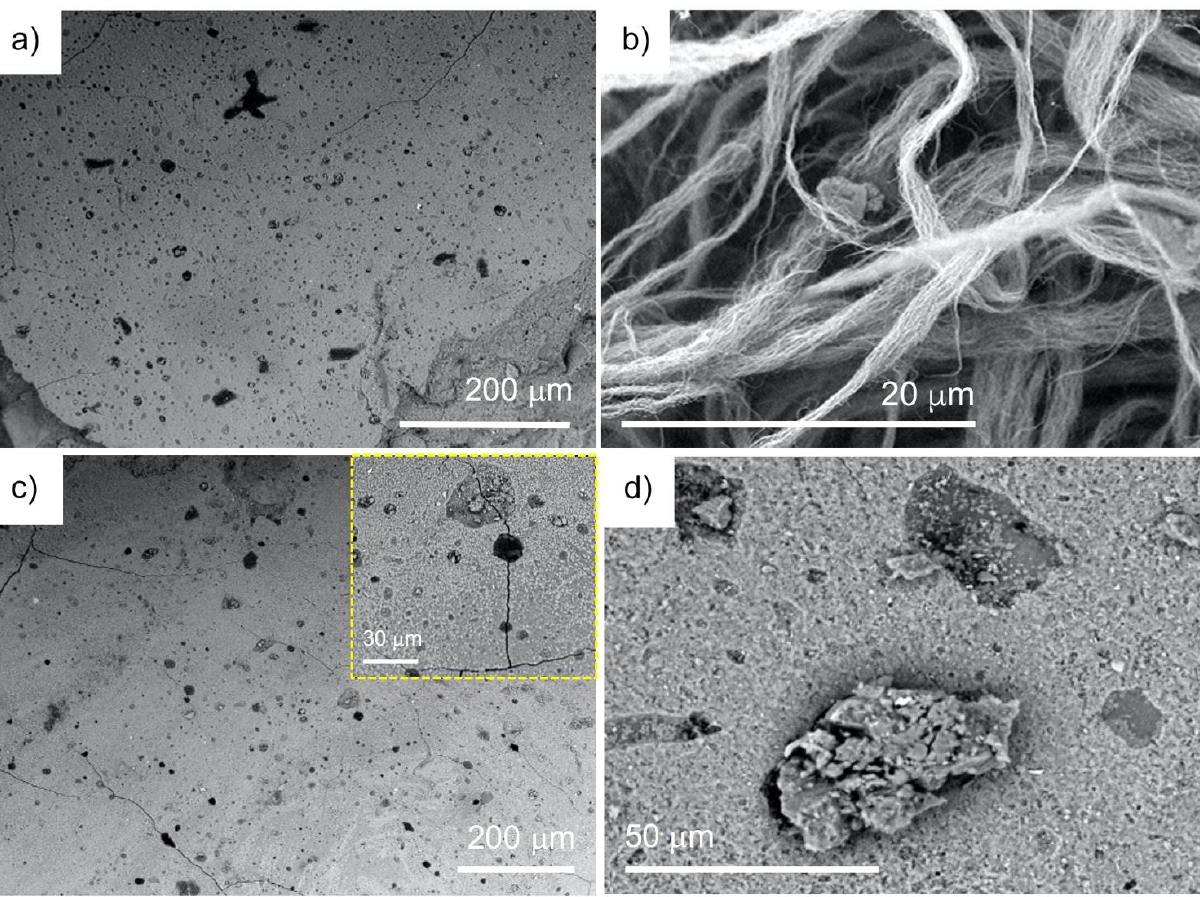
Figure 2. SEM images of: geopolymer ( a ), in-house MWCNTs ( b ), geopolymer nanocomposites containing 0.5 wt.% and 1 wt.% of in-house MWCNTs ( c , d ); the insets correspond to the indicated magnifications revealing the nanotube agglomerates.